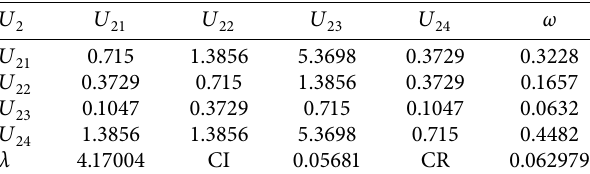
Table 6: Indicator judgement matrix and the weights of the economic risk.